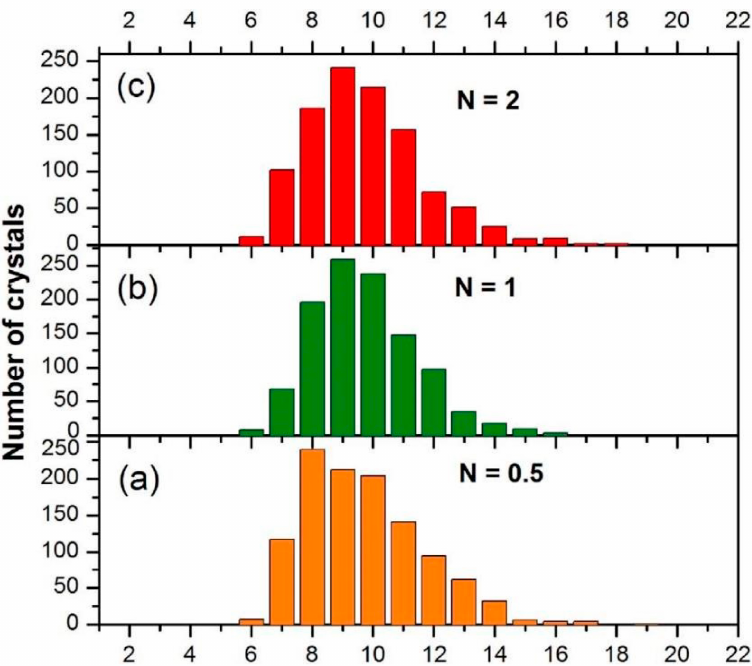
Figure 15. Size distribution for Al 90 Y 10 alloy subjected to HPT at the strain corresponding to ( a ) n = 0.5, ( b ) n = 1, and ( c ) n = 2. Reprinted with permission from ref. [94]. Copyright 2017 Elsevier.